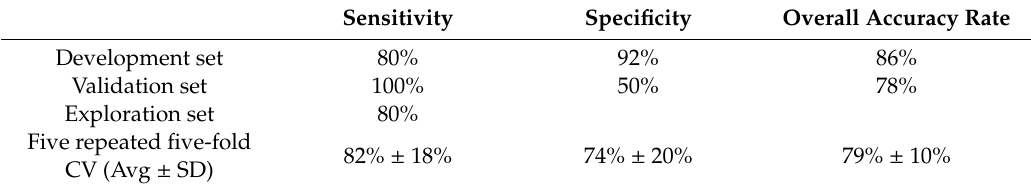
Table 4. Prediction capability of the 3-AA logistic regression biomarker